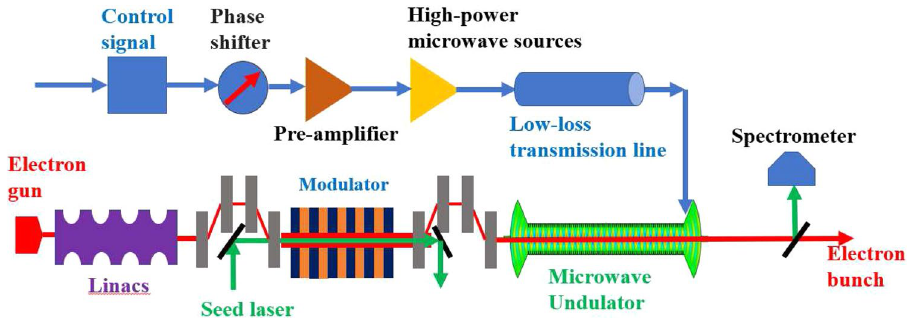
Figure 1. Experimental setup of the microwave undulator.